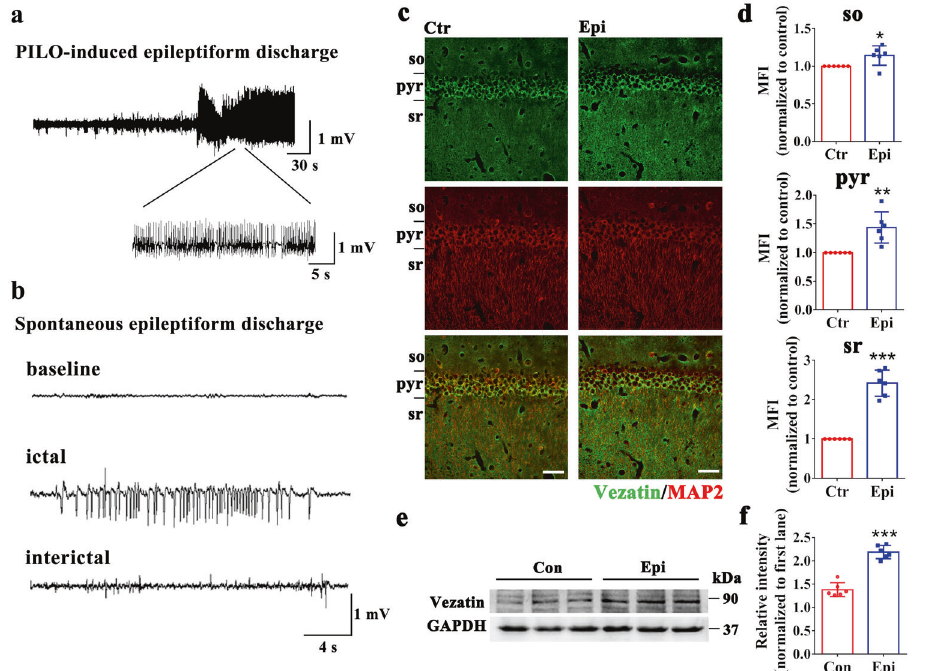
Fig. 1 The pattern of vezatin expression in the PILO-induced epilepsy model. a Representative image of PILO-induced epileptiform discharges in the acute stage and ( b ) representative image of spontaneous epileptiform discharges in the chronic stage. c Representative images of immuno fl uorescence staining demonstrating that in both the control group and epilepsy group, vezatin (green) was expressed in the hippocampal CA1 region, which was divided into three layers: the stratum oriens (so), pyramidal cell layer (pyr), and stratum radiatum (sr). Vezatin (green) was colocalized with the neuronal and dendritic marker MAP2 (red). d Statistical analysis of the MFI of vezatin in the three layers of the CA1 region ( n = 6 per group; so, P = 0.043; pyr, P = 0.003; sr, P < 0.001). e Representative images of western blots showing hippocampal vezatin expression in the control (Con) group and epilepsy (Epi) group and ( f ) the corresponding statistical analysis ( n = 6 per group, P < 0.001). Student ’ s t test; * P < 0.05, ** P < 0.01, and *** P <